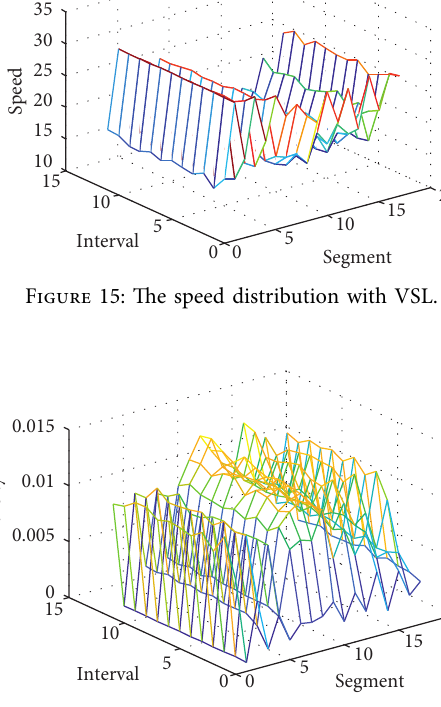
Figure 16: The VSL-integrated mesomodel.